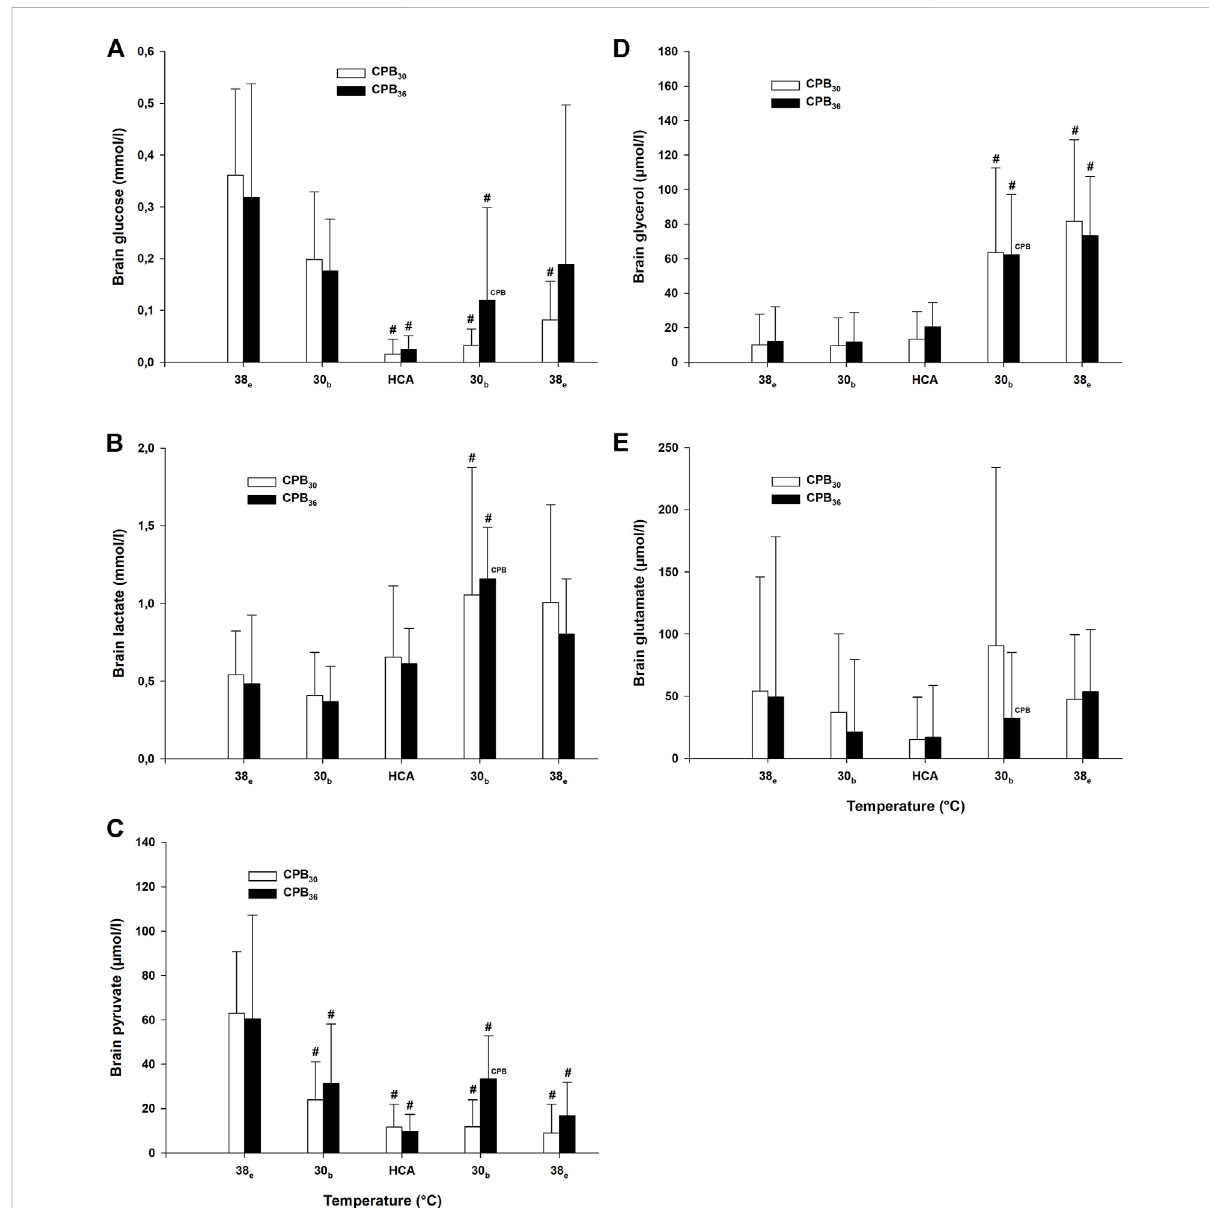
FIGURE 6 Brain microdialysate analyses. (A) : brain glucose, (B) : brain lactate, (C) : brain pyruvate, (D) brain glycerol, (E) : brain glutamate. Temperature measured in: e – esophagus; b – bladder. HCA – hypothermic cardiac arrest. Data presented as mean and SD. # p < 0.05 vs. intragroup baseline; CPB – variables measured during ongoing